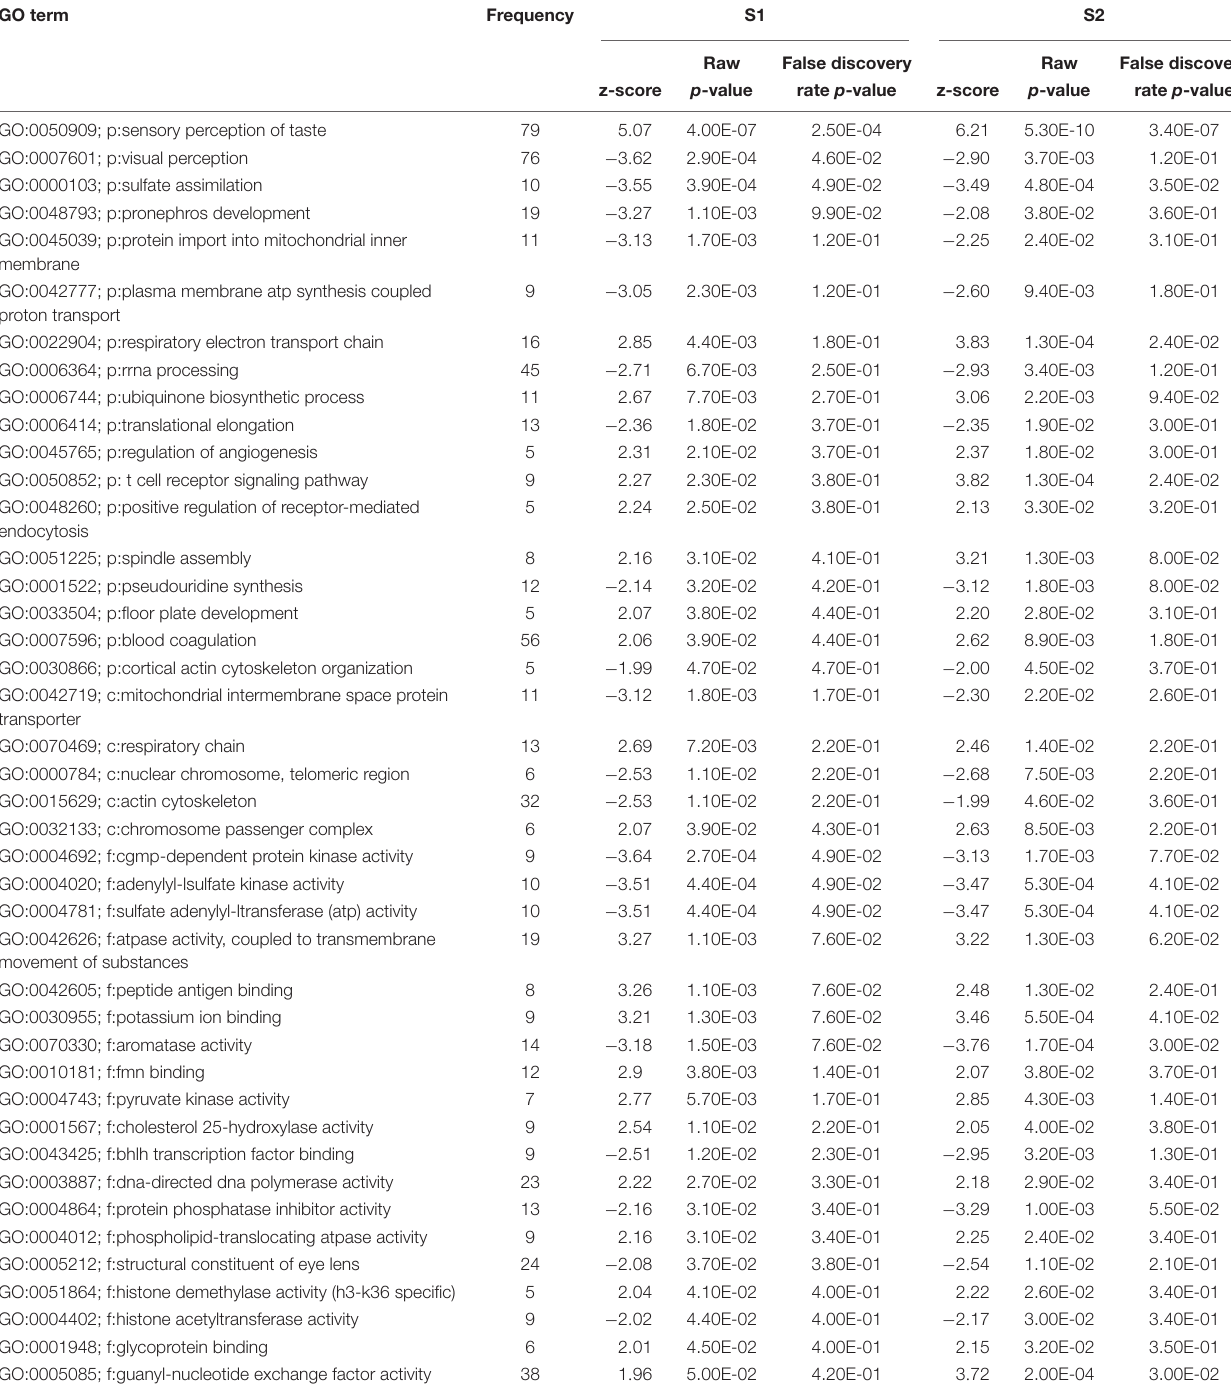
TABLE 2 | List of gene ontology terms (biological process (p:), cellular component (c:) and molecular function (f:) altered after the exposure of S. tropicalis to both S1 and S2 using Parametric Analysis of Gene Set Enrichment (PAGE) analysis ( p < 0.05). GO term Frequency S1 S2 Raw False discovery Raw False discovery z-score p -value rate p -value z-score p -value rate p